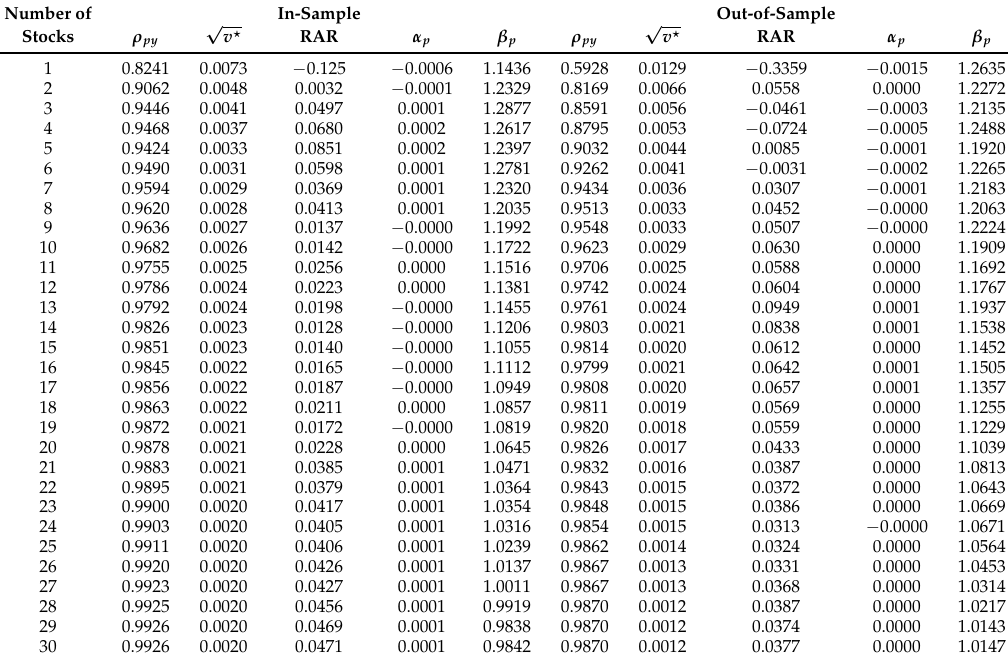
Table 3. Optimal tracking portfolios for DJIA index: Algorithm